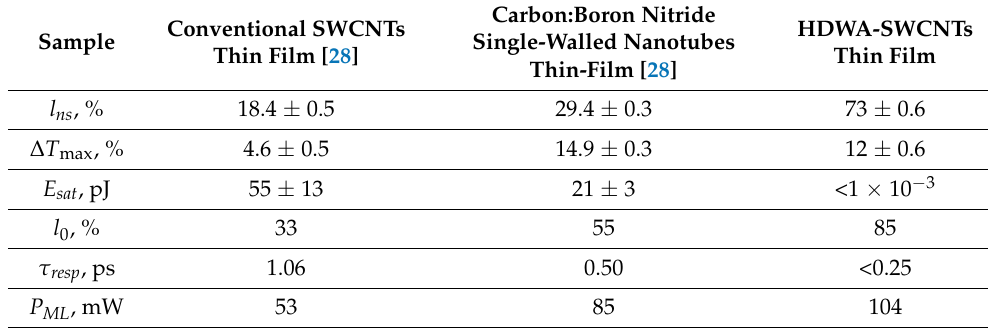
Table 1. SWCNTs thin films parameters, along with the corresponding ML laser parameters. Sample